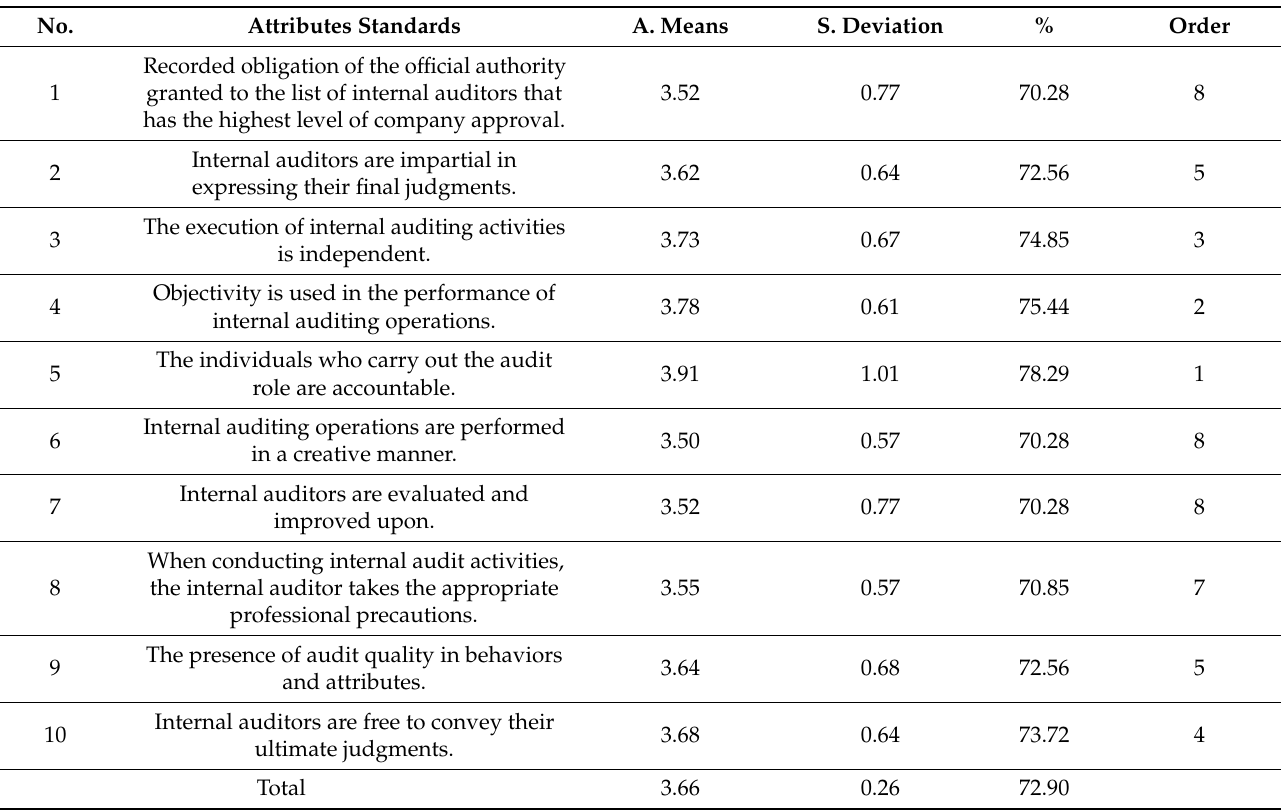
Table 4. The outcomes of the Attributes Standards.